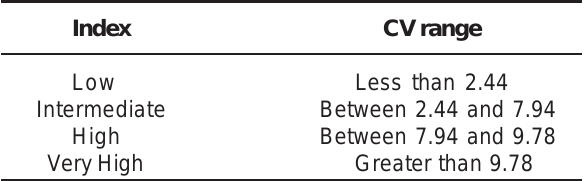
TABLE 2- Classification of the Coefficient of Variation